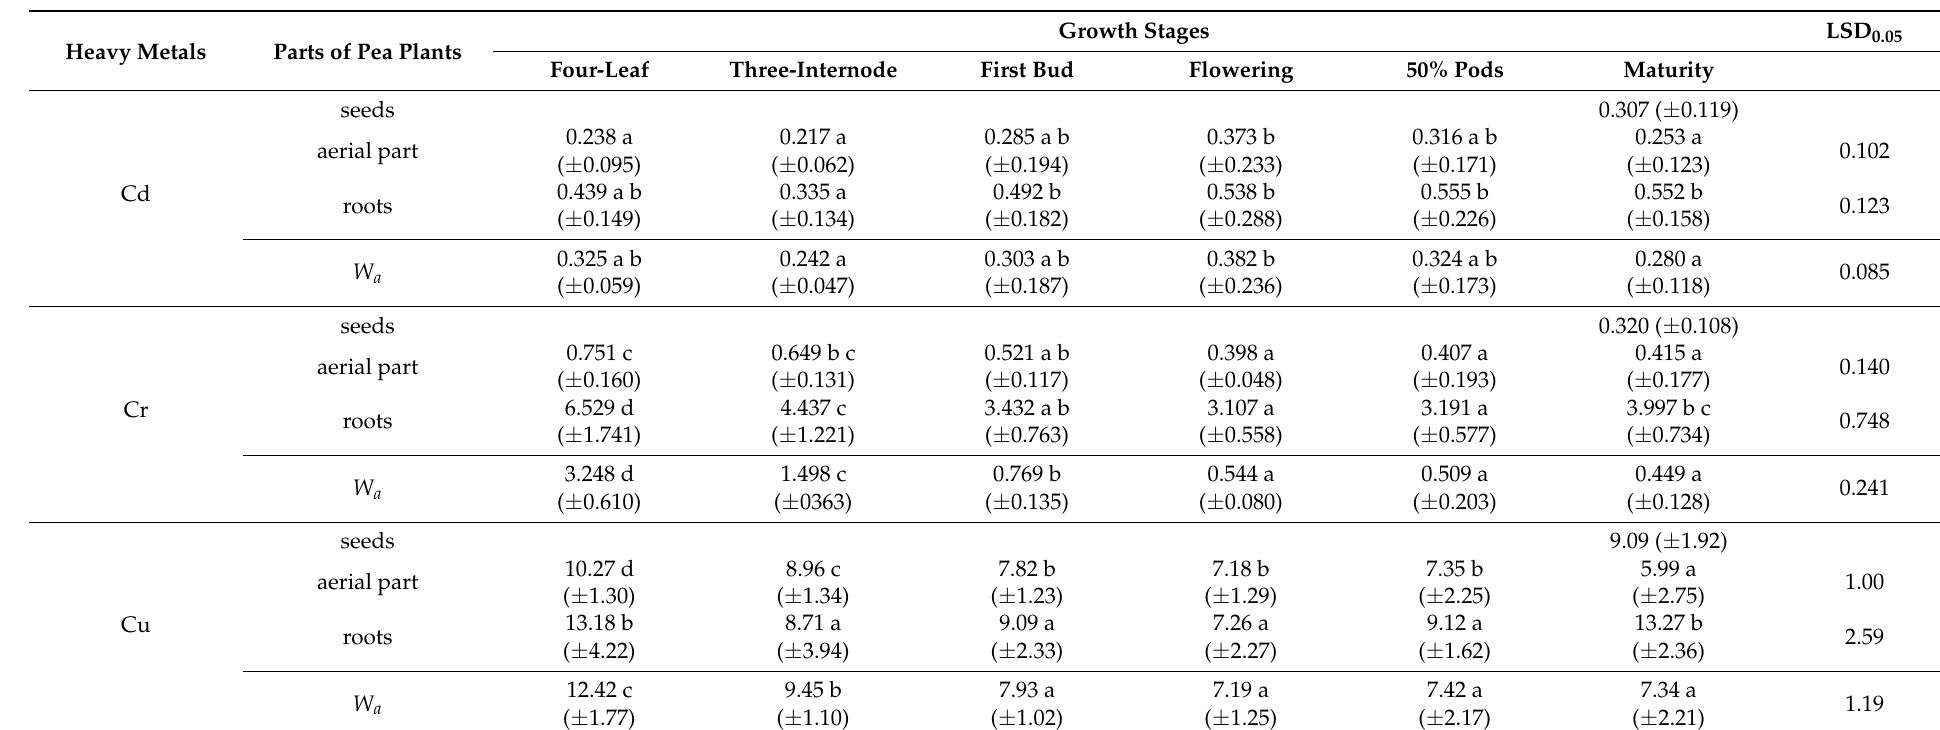
Table 3. Heavy metal content in pea plants in successive growth stages, mg · kg − 1 DW (mean values ± SD of two cultivars and two successive years with three repetitions